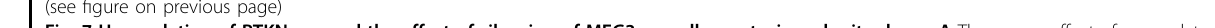
Fig. 7 Upregulation of RTKN rescued the effect of silencing of MEG3 on cell apoptosis and mitophagy. A The rescue effect of upregulated RTKN on silenced MEG3 in caspase-3 activity was evaluated via a caspase-3 activity kit. B , C TUNEL assay revealed the rescue effect of upregulated RTKN on silenced MEG3 in the number of TUNEL-positive cells. D Western blot analysis showed the protein levels of Parkin, p62, LC3B-I, and LC3B-II in IR-treated HK-2 cells transfected with sh-MEG3 + pcDNA3.1-RTKN. E , F Mitophagy fl ux was assessed in IR-treated HK-2 cells after cotransfection with sh-MEG3 + pcDNA3.1-RTKN. Red color indicated DMSO and blue color indicated Baf. G ATP production in IRI-treated HK-2 cells cotransfected with